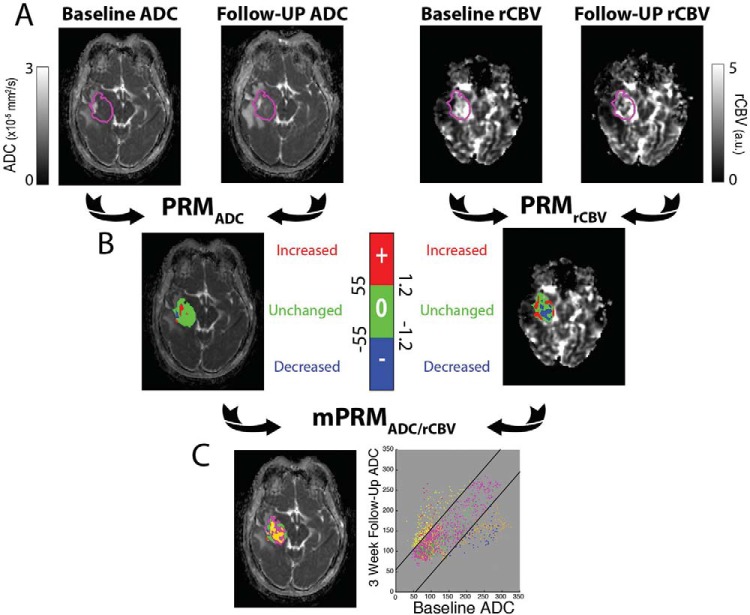
Schematic of the multiparametric PRM technique. (A) Parametric maps of ADC from DW-MRI (left) and rCBV from DSC-MRI (right) acquired before and midway through therapy. (B) The PRM approach was applied to the individually ADC and rCBVs, resulting in 3 classifications each. PRM results are presented as a 3-color overlay that represents regions in which tumor parameter values (ie, ADC or rCBV), based on predetermined thresholds, are unchanged (green voxels), significantly increased (red voxels), or significantly decreased (blue voxels). (C) The individual PRMs are combined, resulting in 9 classifications (2 parameters and 3 classes, resulting in 32 = 9 classes for mPRM). Analogous to mPRM, results are presented as a visual map in which individual voxels are colored by classification as well as presented within a scatter plot. Global measures are presented as relative tumor volumes and calculated as the sum of all voxels in a class normalized to the tumor volume.